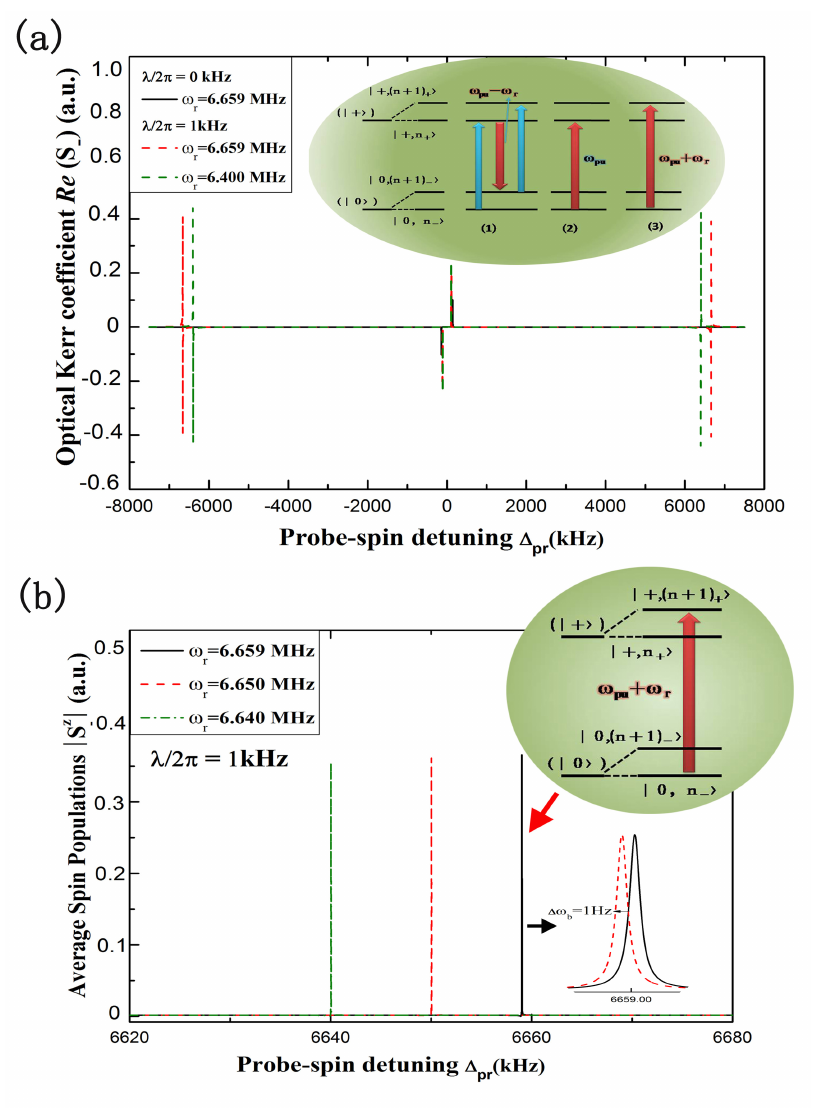
Figure 2. ( a ) The optical Kerr coefficient as a function of the detuning of the probe field from the spin resonance with two vibrational frequencies of the hybrid spin-microcantilever ω / 2 π = 6 . 659 MHz and ω / 2 π = 6 . 400 MHz for Ω 2 = 100 (kHz), ∆ = 0 and r r pu pu λ/ 2 π = 1 kHz. Additionally, the new features in the spectrum shown are identified by the corresponding transition between the dressed states of NV center spin, as shown in the (cid:105) as a function of ∆ inset; ( b ) The nonlinear spin resonance spectrums (cid:104) S z corresponding pr − to different vibrational frequencies (all of the other parameters are the same as ( a ). The upper inset shows the underlying physical mechanism for these characteristic peaks. The bottom inset is a partially enlarged view of the characteristic